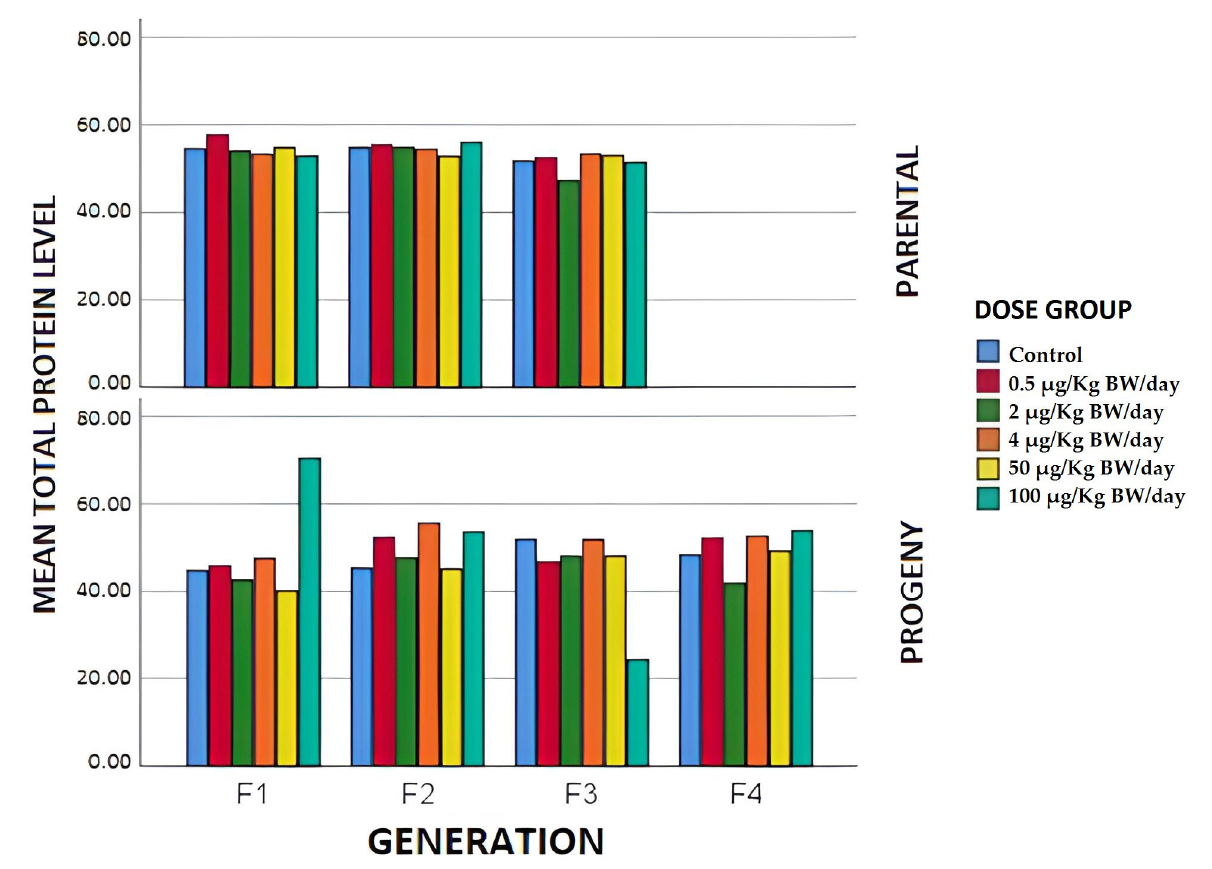
Figure 4. Mean total protein values expressed in g/L in the different generations of breeders and offspring in terms of the exposure group.